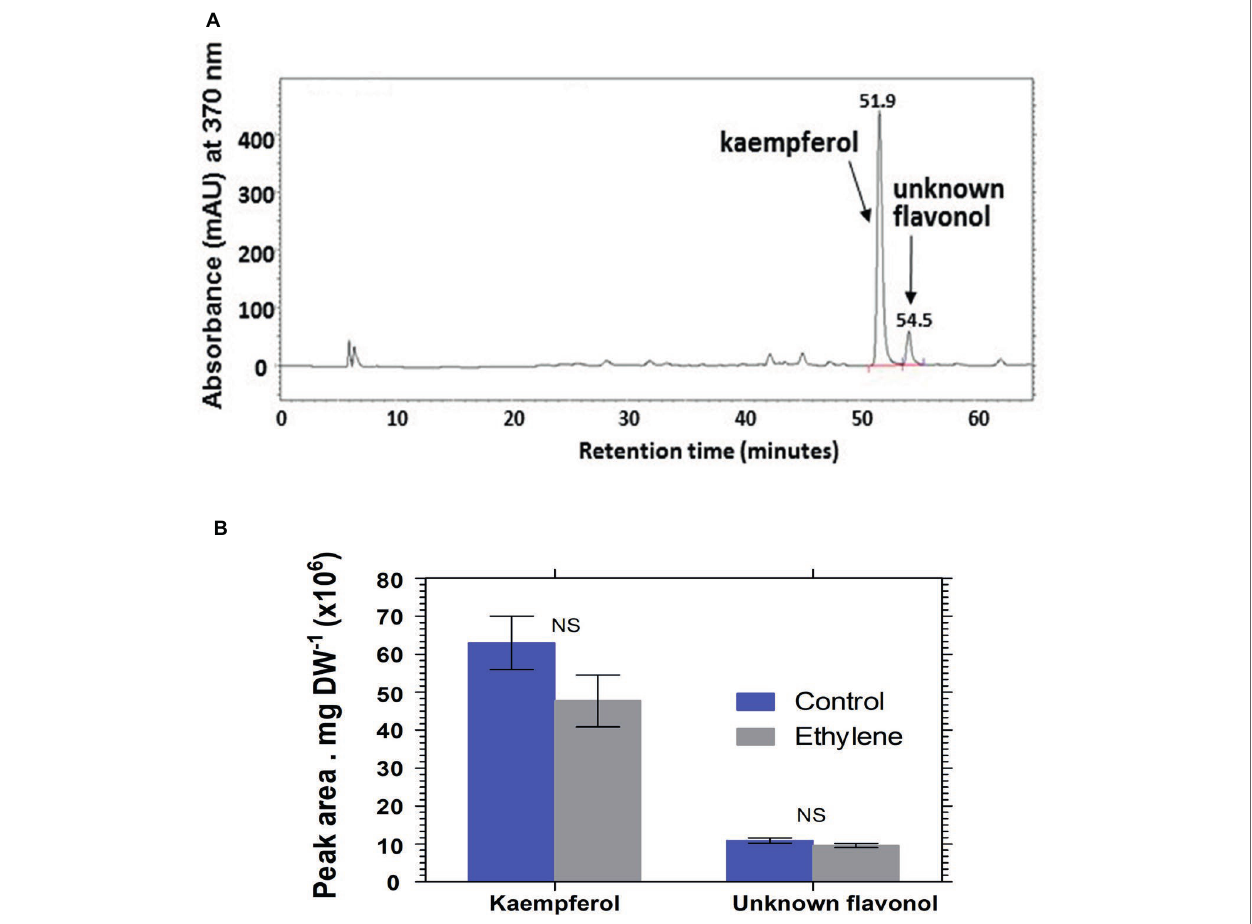
FIGURE 7 | A typical chromatogram profile of flavonols detected in control hydrolyzed samples of Vanda ‘Sansai Blue’ florets (A) , and effect of ethylene treatment on the levels of these flavonols detected 2 days after treatment (B) . The inflorescences were exposed either to air (control) or to 10 μl L −1 ethylene for 24 h at 21 ± 2 ° C. Flavonols were extracted from florets at the bloom developmental stage (see Figure 1A ), 2 days after treatment, hydrolyzed, purified, and chromatographed. The results in graph (B) represent means ± SE of three floret replicates per treatment. NS, not